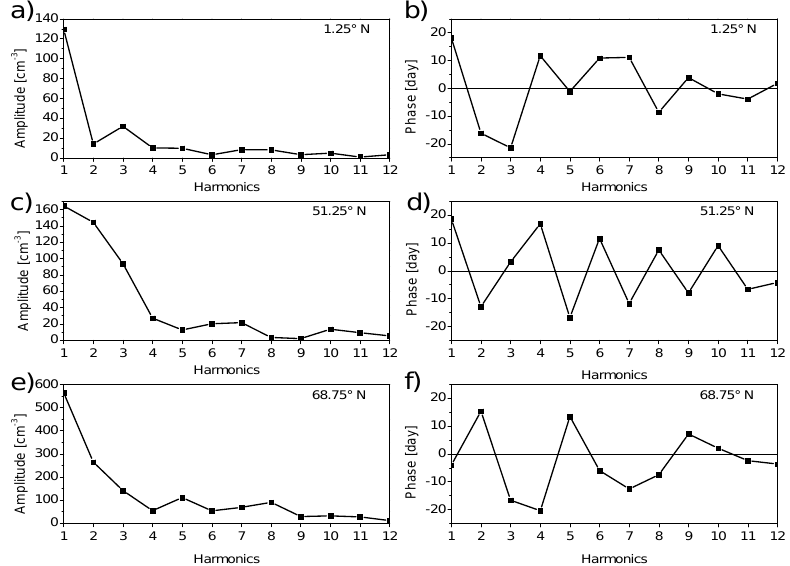
Figure 10. Fourier analysis from a mean year averaged over all 49 years for different latitudes showing the amplitude (left) and the phase